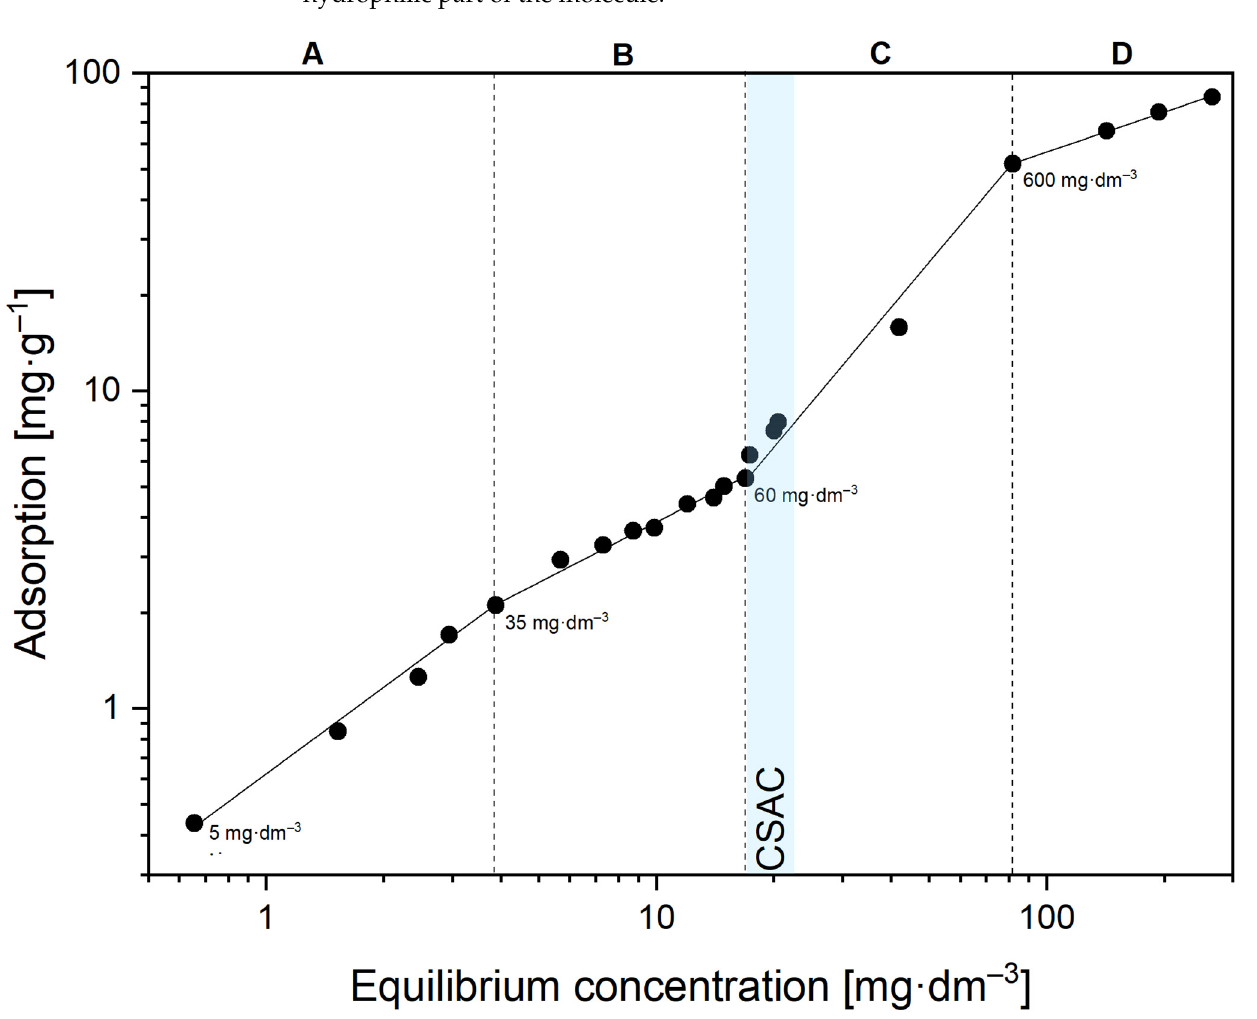
Figure 2. Rhamnolipid adsorption isotherm onto dolomite surface at pH 10. The initial concentration of the RL solution (5, 35, 60, 600 mg ∙ dm − 3 ) at the beginning of each surfactant adsorption region ( A – D ) was depicted. CSAC (critical surface aggregation concentration) in this system occurs at around 60–75 mg ∙ dm − 3 of the initial RL concentration.